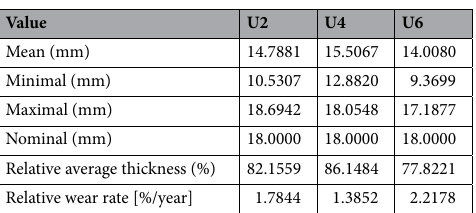
Table 2. Parameters for the longitudinal section—testing the device